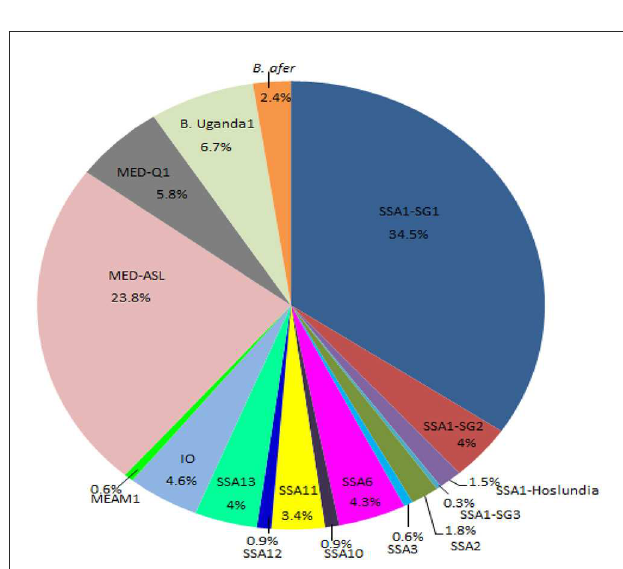
FIGURE3 Percentage composition of all the whitefly species collected from the different agro-ecological regions in Uganda during May/August 2017. SSA, sub-Saharan Africa; SG, sub-group; MED, Mediterranean; ASL, African silver leafing; IO, Indian Ocean; B. afer, Bemisia afer ; MEAM1, Middle East-Asia Minor1 and B. Uganda1, Bemisia